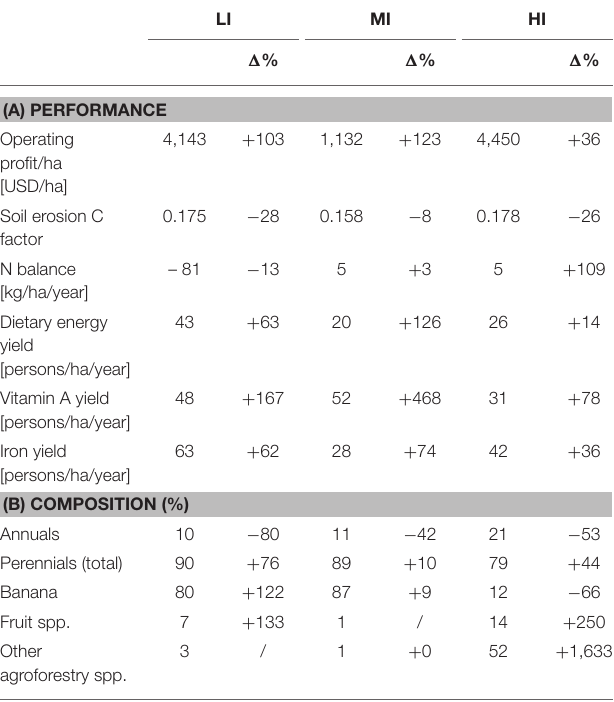
TABLE 5 | Performance (A) and composition (B) of the best redesign with C. calothyrsus integrated on farm, as calculated by the FarmDESIGN model, and the percentage change in objectives (A) and farm components (B) relative to the original farm